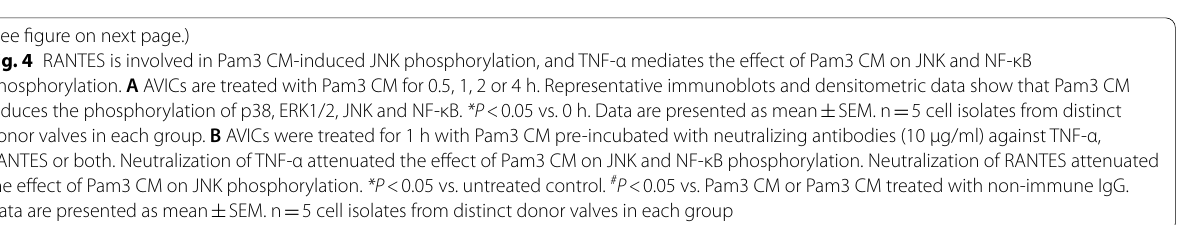
SEM. n 5 cell isolates from distinct ± =